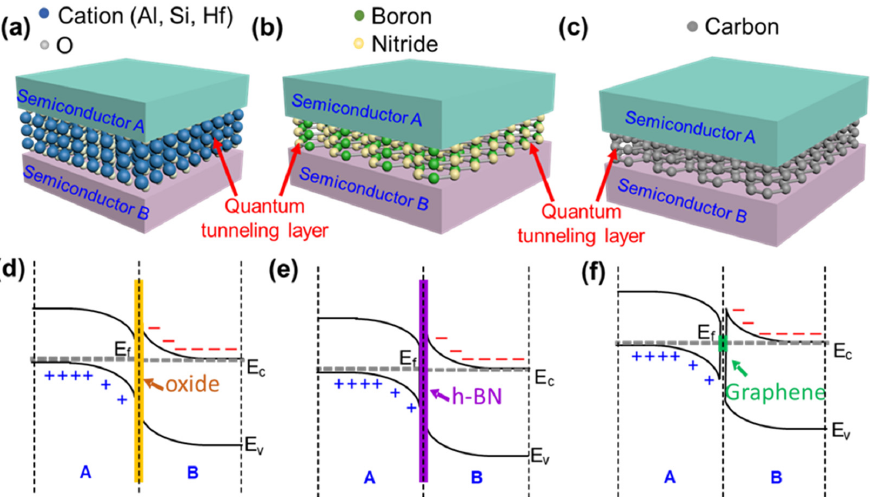
Figure 1. A schematic illustration of the semiconductor heterostructure formed by various ultra-thin tunneling intermediate layers: ( a ) oxide materials such as Al 2 O 3 , HfO 2 , and SiO 2 ; ( b ) 2D materials such as h-BN and ( c ) graphene; and ( d – f ) their corresponding generic band diagrams.